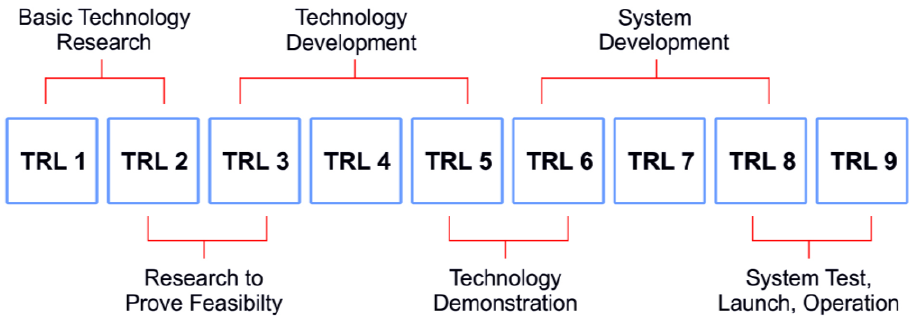
Figure 10. General schematics of TRL assessment (Based on [101]).